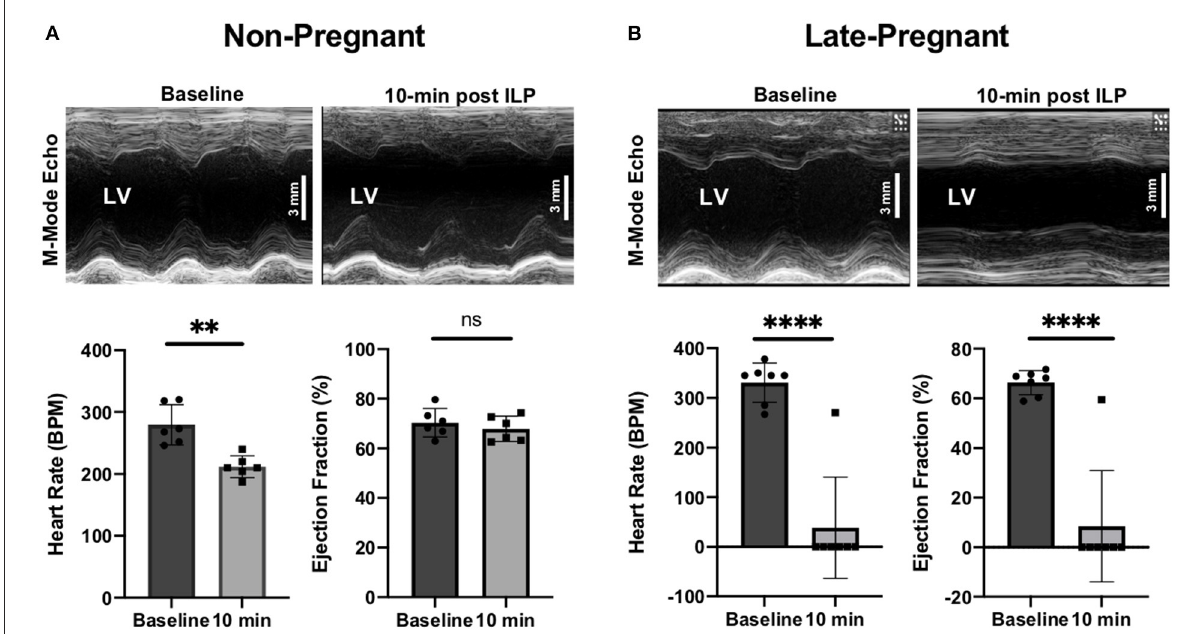
FIGURE2 M-Mode transthoracic echocardiographs at baseline and 10-min after intralipid (ILP) bolus showing left ventricular ejection fractions (LVEF, %) and heart rate (beats per minute, bpm) at baseline and 10-min after ILP bolus in non-pregnant (NP) (A) and late-pregnant (LP) (B) rats. ** P